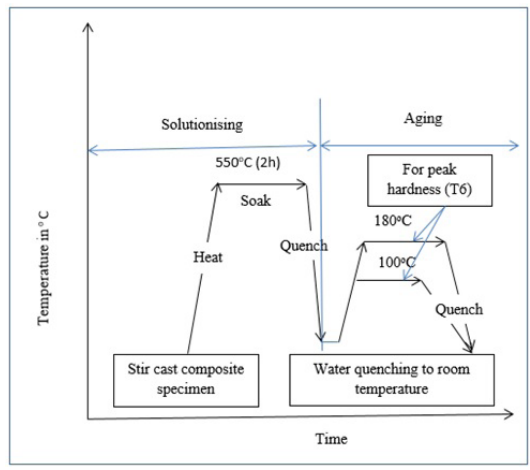
Figure 2. Conventional age hardening treatment.